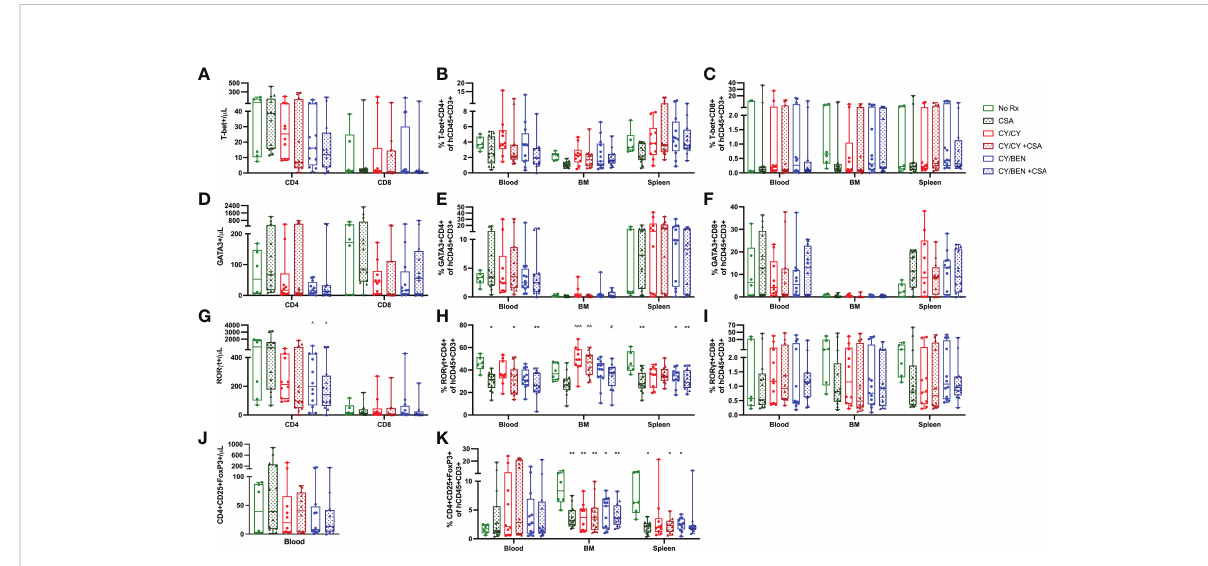
FIGURE 7 T helper 17 in fl ammatory T cell polarization and T-regulatory cell percentages are modestly different at day 31 with post-PBMC chemotherapy treatment. Blood, bone marrow and spleen were collected from animals at day 31 post-PBMC infusion and prepared for fl ow cytometric analysis as described in Materials and Methods. All subsets were gated from CD45+CD3+ cells and identi fi ed as speci fi c T helper subsets via the presence of their respective transcription factors: (A-C) T helper 1 cells: T-bet+. (D-F) T helper 2 cells: GATA3+. (G-I) T helper 17 cells: ROR g t+. (J, K) Regulatory T cells: CD4+CD25+FoxP3+. (A, D, G, J) Absolute counts of each T helper subset present in blood were determined with the use of counting beads. (A-K) Signi fi cant differences across treatment groups were evaluated via a one-way ANOVA followed by Tukey ’ s post- hoc test. P values are indicated by the number of symbols between groups, *<0.05, **<0.01, ***<0.001. Asterisks (*) indicate signi fi cant differences from vehicle group, arrows (^) indicate differences from CSA group, and pound symbols (#) indicate differences from CY/CY